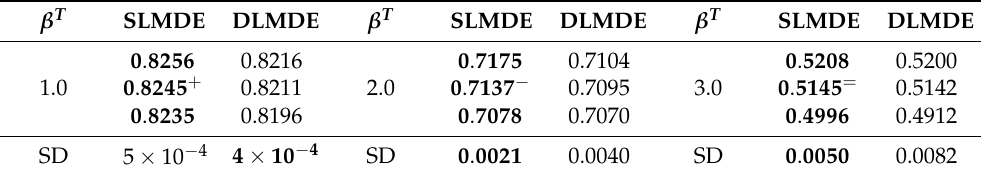
Table 7. Best, median, and worst HV values obtained via both methods, presented for car side impact example for different values of β T . The best performances are highlighted in bold font.